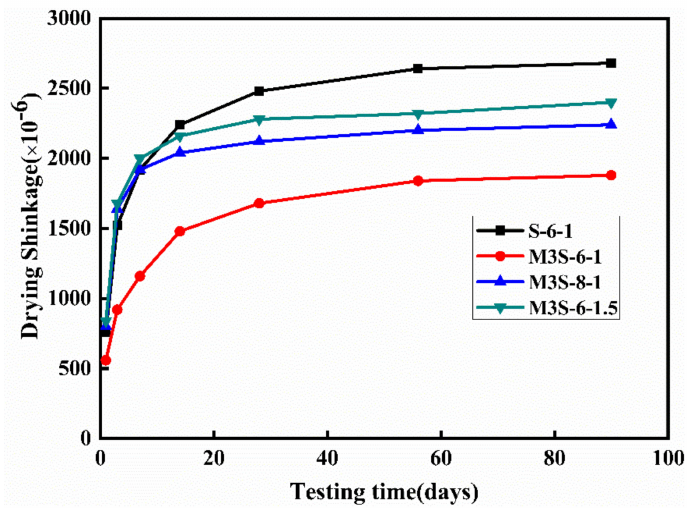
Figure 11. Effects of activator concentration and modulus on the drying shrinkage of alkali-activated slag mortar with 30%